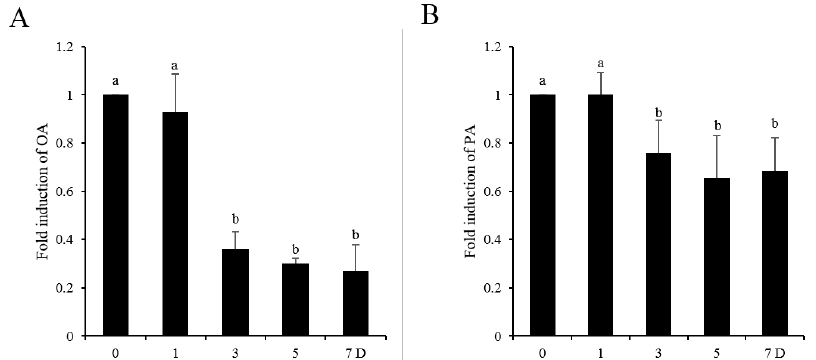
Figure 1. The levels of OA (A) and PA (B) in sperm were decreased during the liquid storage at 17 °C. Values are specified as the mean ± standard deviation (SD). Columns with different lowercase letters differ significantly (p ＜ 0.05). OA: oleic acid. PA: palmitic acid.